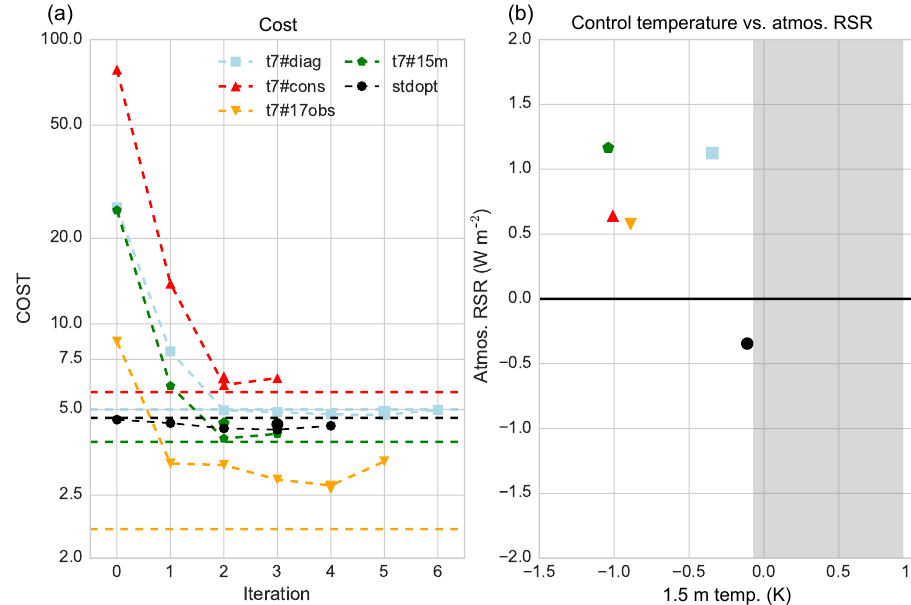
Figure 10. (a) Cost as function of iteration for four trial 7-parameter and stdopt cases (lines and symbols). Also shown are the cost functions for the standard model for each case (coloured horizontal lines) with the colour corresponding to the trial case. Large symbols for each trial case show cost from independent atmospheric simulation with other details, as in Fig. 1. (b) Scatter plot (symbols as a ) of optimal minus standard configurations for 2000–2010 mean RSR from atmospheric-only simulations against the coupled control mean for years 10–19 of 1.5m temperature. Vertical grey region show estimates of the difference between pre-industrial global-average air temperatures and the standard configuration; configurations in this region are